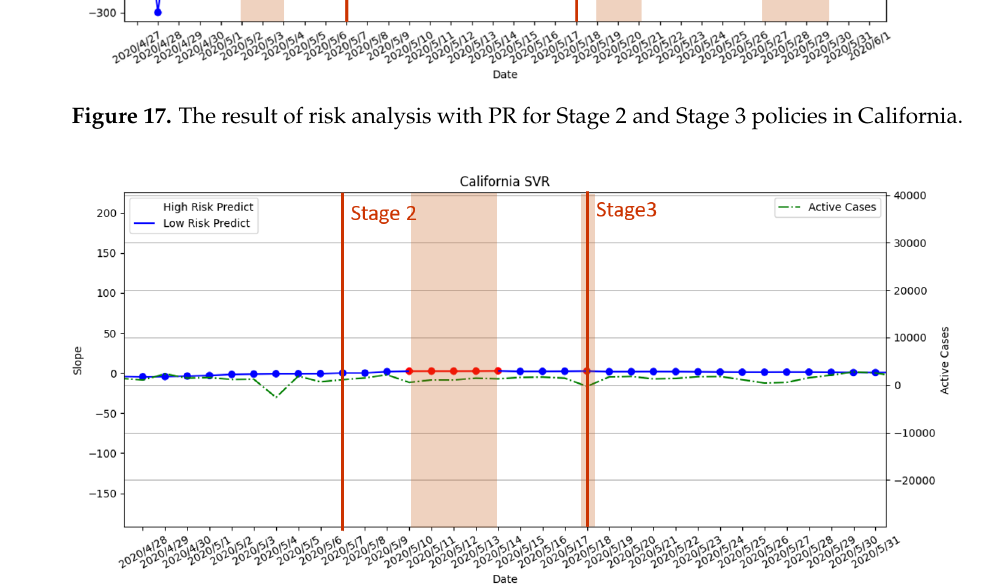
Figure 18. The result of risk analysis with SVR for Stage 2 and Stage 3 policies in